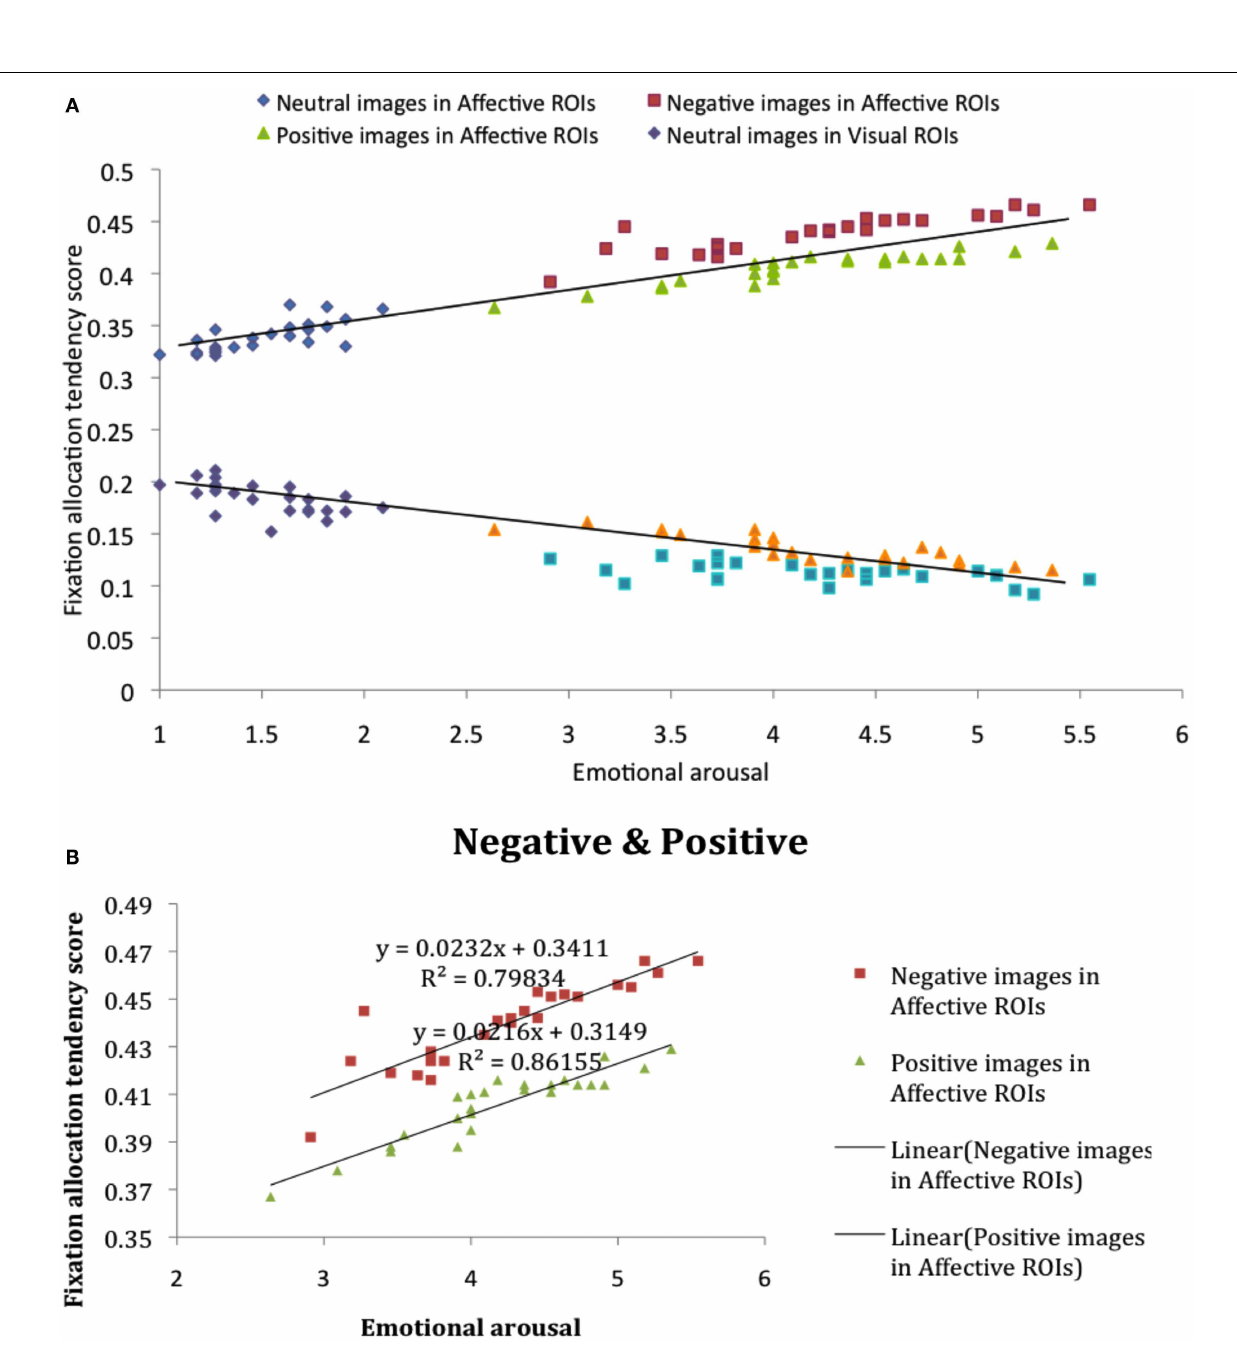
for negative and smallest for neutral images, F (2, 72) = 276.45, p < 0.001, η 2 = 0.88. Pairwise contrasts showed that for each emo- tion category ROI difference scores differed from the other two categories ( p ’s < 0.001). In order to further compare the influence of emotion category on sequential looking order in affectively